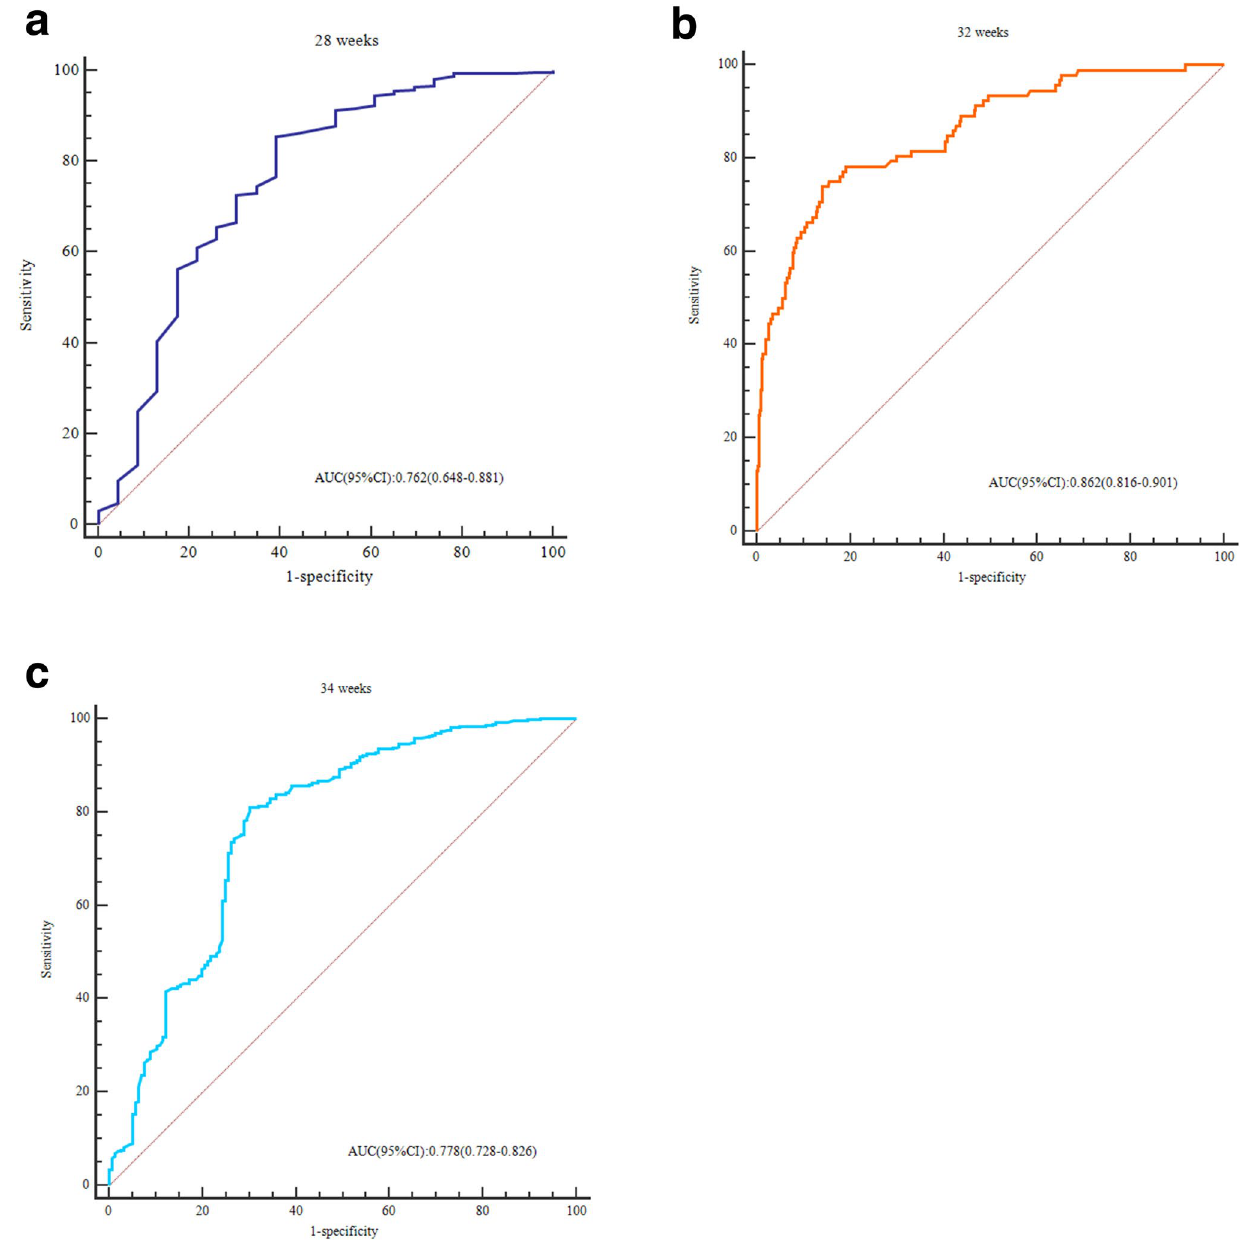
Figure 2. ROC curves for three gestational weeks at delivery (before 28 weeks, 32 weeks and 34